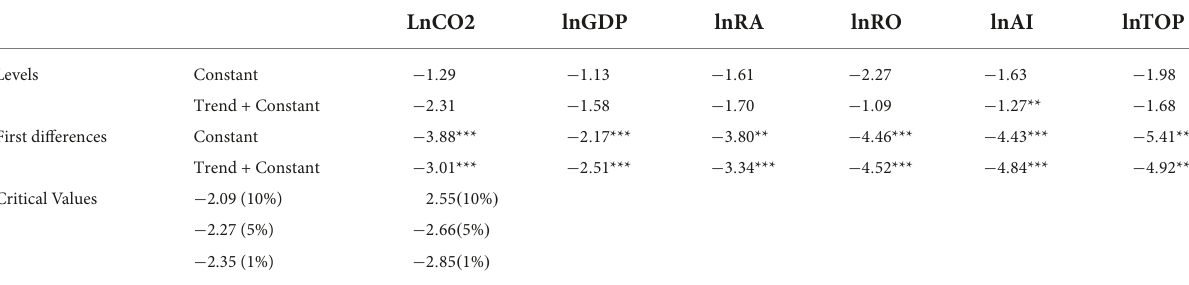
TABLE 3 The results of CIPS unit root